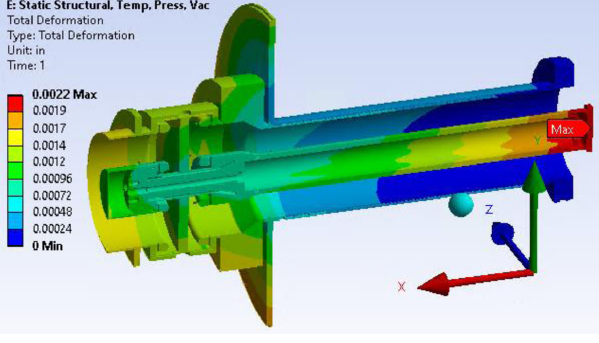
FIG. 15. Thermal-mechanical simulation result.